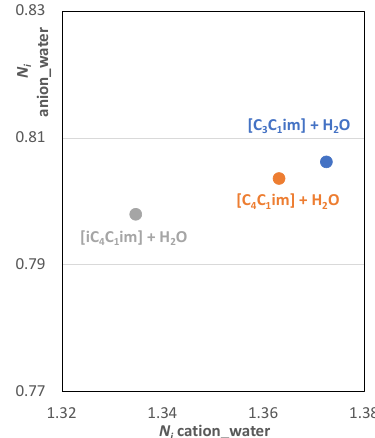
Figure 6. Average number of water neighbors around the cation ( N i cation_water) vs. the anion ( N i anion_water) for aqueous mixtures X IL = 0.70 (wt IL = 98%) of [C 3 C 1 im][NTf 2 ], [C 4 C 1 im][NTf 2 ], and [iC 4 C 1 im][NTf 2 ].